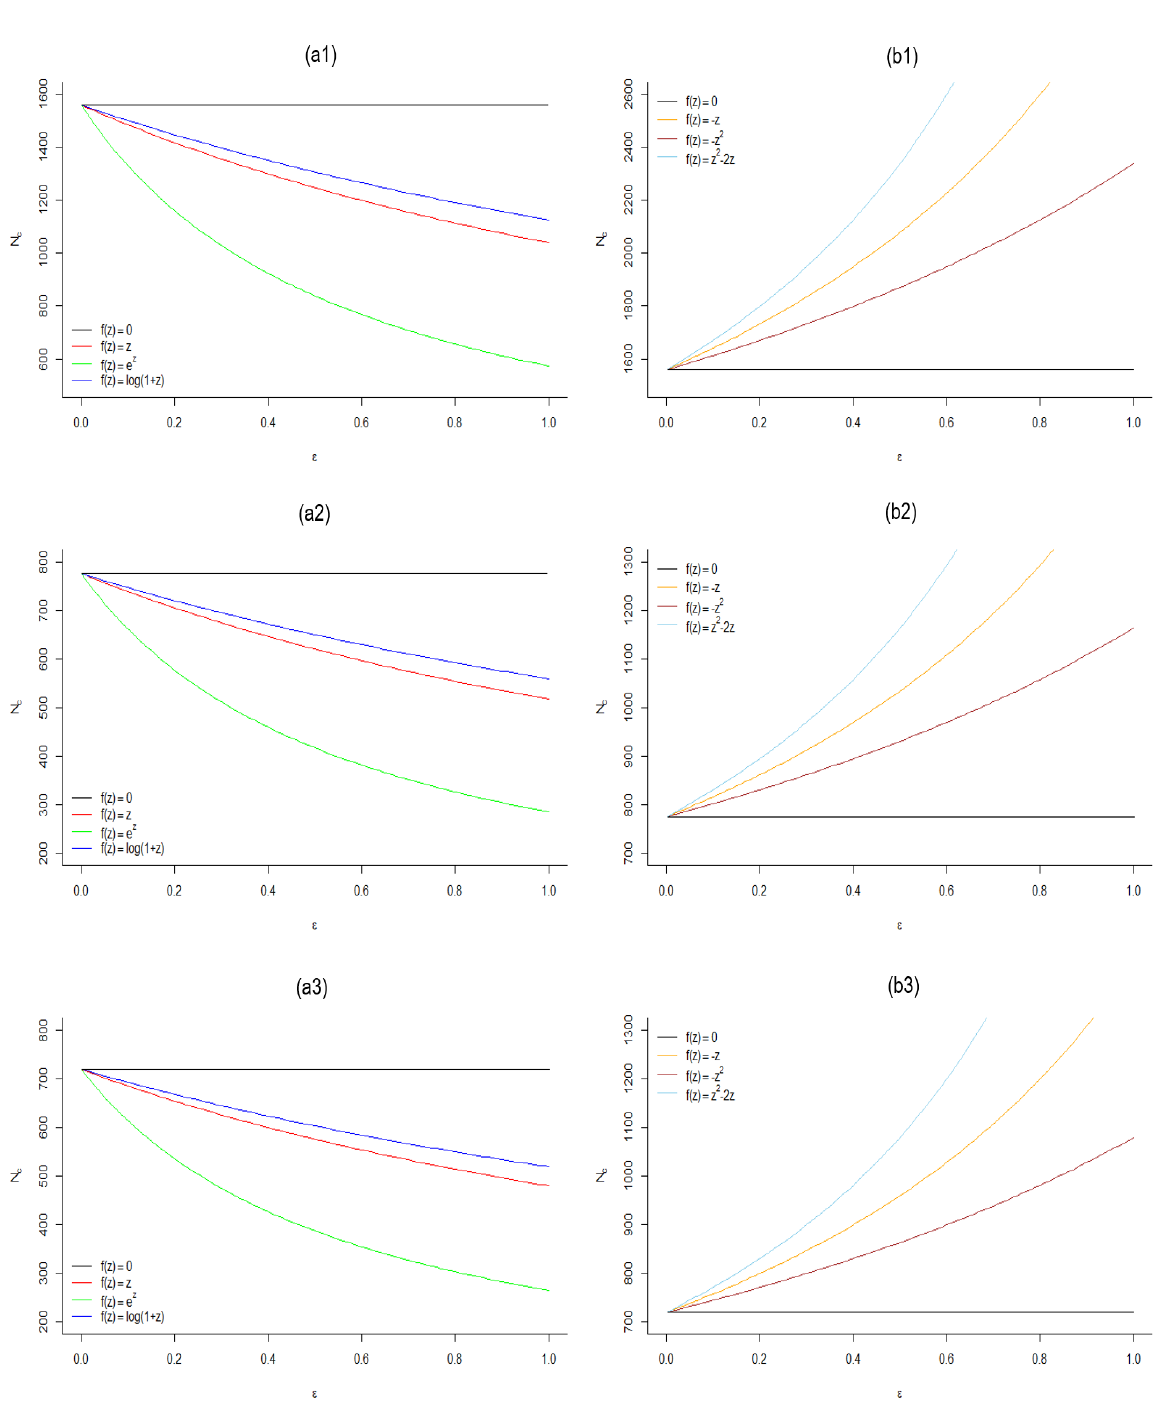
Figure 3. For different changeable gravity function, relationship between N c and (cid:101) , for δ = 0 and M 3 = 1 in ( a1 , b1 ), for δ = 0 and M 3 = 10 in ( a2 , b2 ), for δ = 0 and M 3 = 20 in ( a3 ) and ( b3